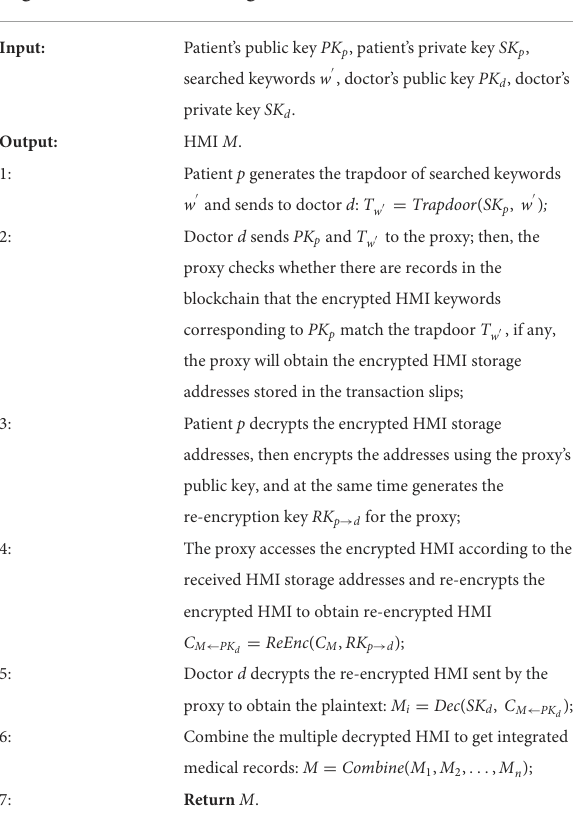
TABLE 4 Pseudocode of sharing data. Algorithm